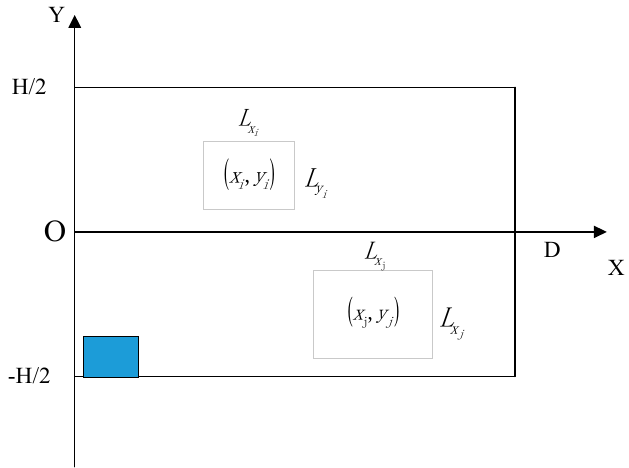
Figure 2. Diagram of cabin equipment.